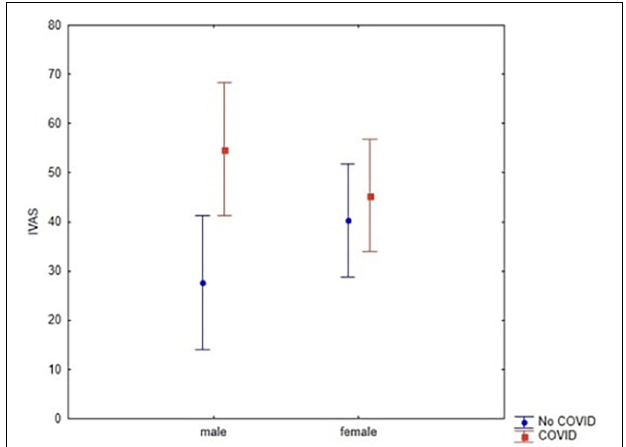
FIGURE 3 | Interaction between Diagnosis and Gender ( F = 9.08; p = 0.003) through BDI-II scores. Vertical bars denote 0.95 confidence intervals.